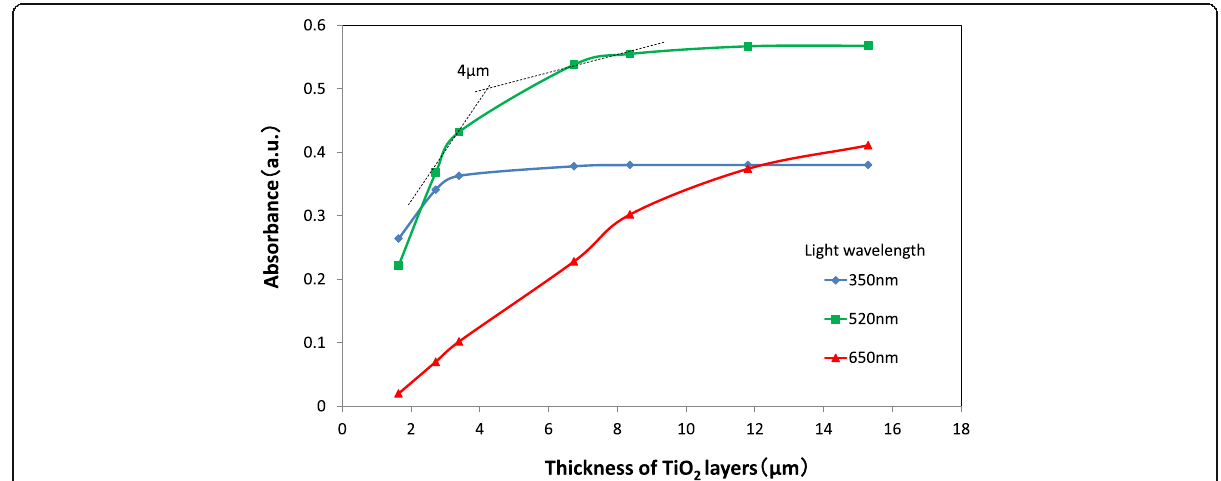
Fig. 13 Correlation between light absorbance at various wavelengths and thicknesses of the TiO 2 layers